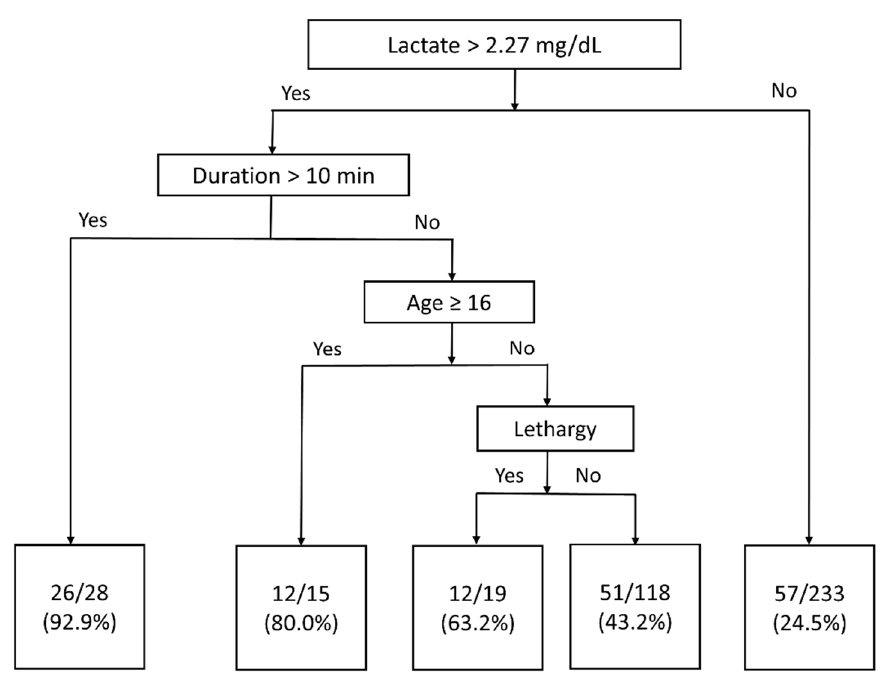
Figure 3. Decision tree for the 417 pediatric patients with new-onset afebrile seizures. The percentages in the bottom boxes represent the risk of epilepsy development.